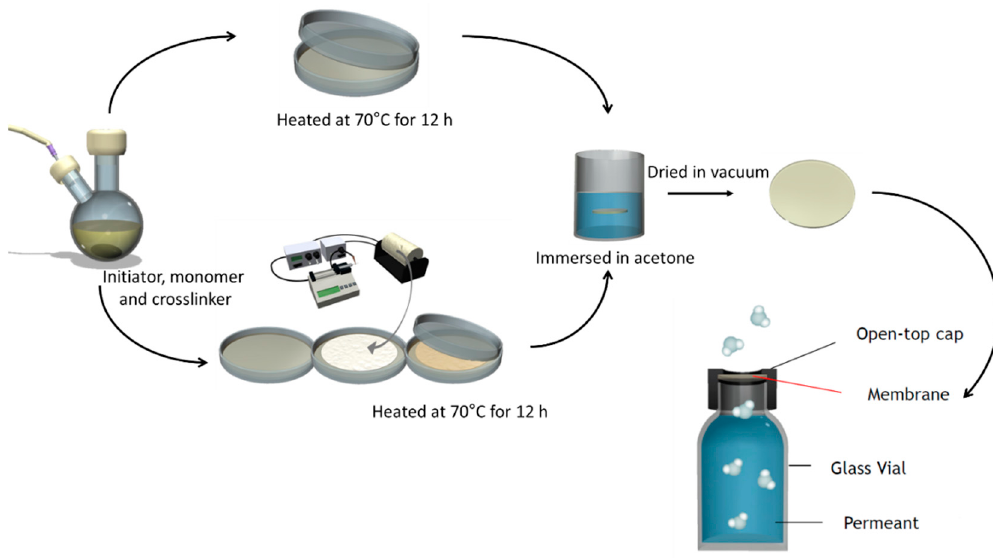
Figure 1. Scheme of membrane preparation and vapor permeation testing cell.